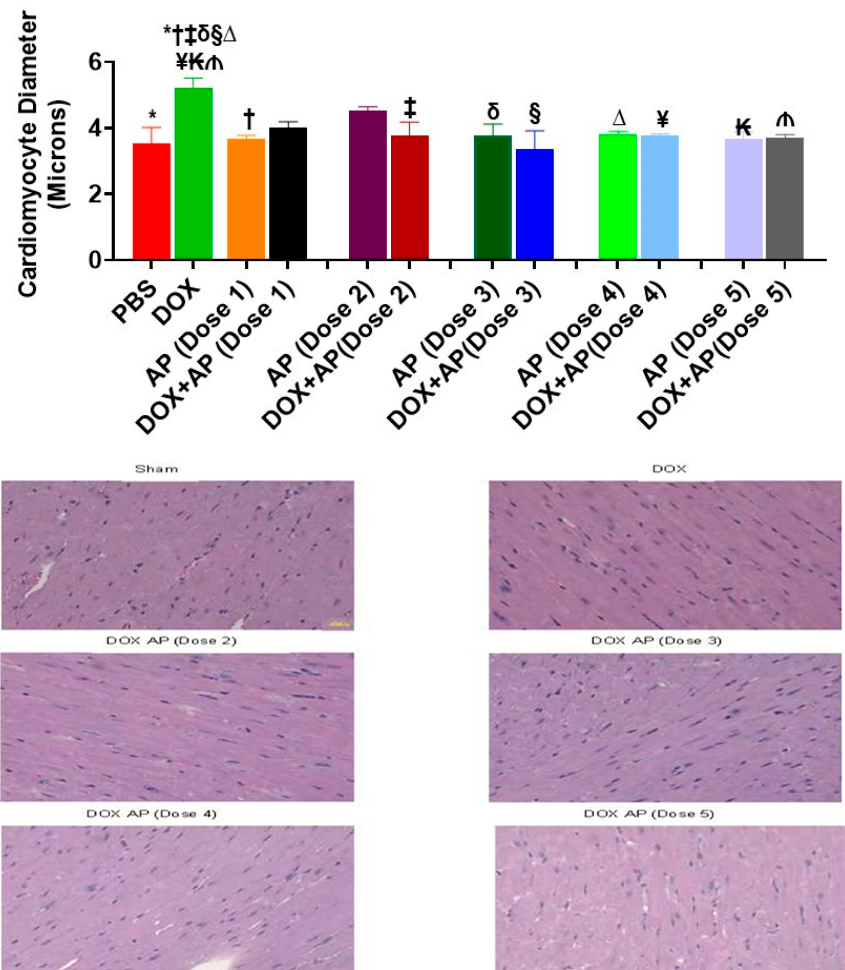
3.3. Effect of Aprepitant on Doxorubicin Induced Cardiomyocyte Hypertrophy Compared to the sham control (vehicle treated group), the mean cardiomyocyte di- ameter (expressed in terms of microns) was significantly increased in response to DOX (Figure 3; DOX; 5.22 ± 0.28 µ m, n = 4 vs. vehicle; 3.54 ± 0.47 µ m, n = 2: p = 0.03, (Figure 3; DOX; 5.22 ± 0.28 µm, n = 4 vs. vehicle; 3.54 ± 0.47 µm, n = 2: p = 0.03, ANOVA ANOVA with Tukey’s post hoc test). Importantly, all 5 Dose of aprepitant attenuated with Tukey’s post hoc test). Importantly, all 5 Dose of aprepitant attenuated the DOX- the DOX-induced increases of cardiomyocyte diameter as follows; DOX+AP (Dose 1); induced increases of cardiomyocyte diameter as follows; DOX+AP (Dose 1); 4.015 ± 0.17 4.015 ± 0.17 µ m, n = 3, DOX+AP (Dose 2); 3.75 ± 0.42 µ m, n = 3, DOX+AP (Dose 3); 3.35 ± 0.56 µ m, n = 3, DOX+AP (Dose 4); 3.75 ± 0.07 µ m, n = 3, DOX+AP (Dose 5); µm, n = 3, DOX+AP (Dose 2); 3.75 ± 0.42 µm, n = 3, DOX+AP (Dose 3); 3.35 ± 0.56 µm, n = 3.70 ± 0.097 µ m, n = 3, vs. DOX; 5.22 ± 0.28 µ m, n = 4: p < 0.05 all, ANOVA and Tukey’s 3, DOX+AP (Dose 4); 3.75 ± 0.07 µm, n = 3, DOX+AP (Dose 5); 3.70 ± 0.097 µm, n = 3, vs. test (Figure 3). DOX; 5.22 ± 0.28 µm, n = 4: p < 0.05 all, ANOVA and Tukey’s test (Figure 3).